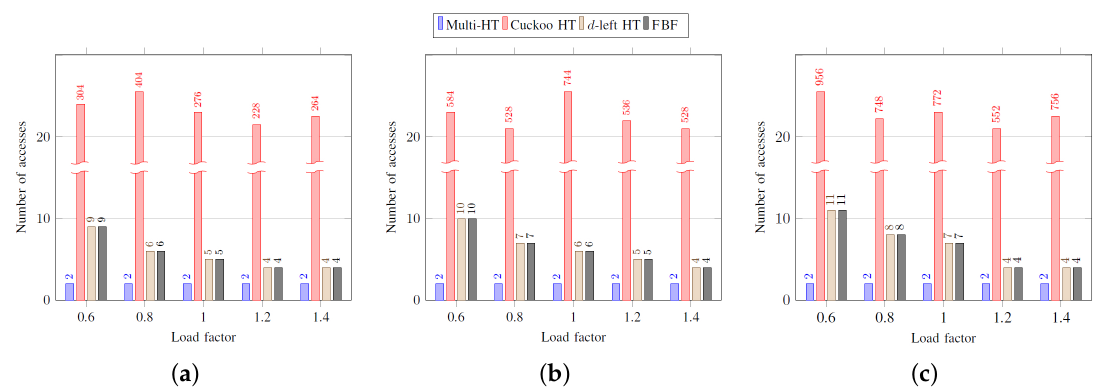
Figure 4. Worst-case number of accesses in inserting an element: ( a ) 8k; ( b ) 32k; ( c ) 130k.